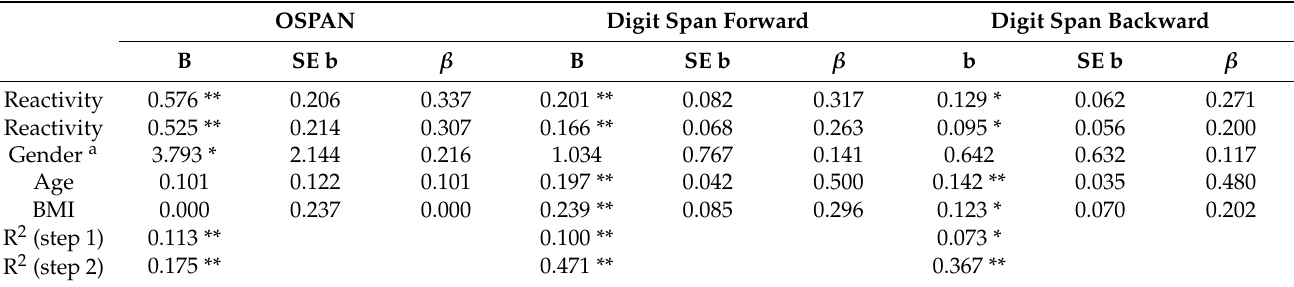
Table 3. Hierarchical linear regression results for the reactivity score predicting the working memory tests (OSPAN test, digit span forward, and digit span backward